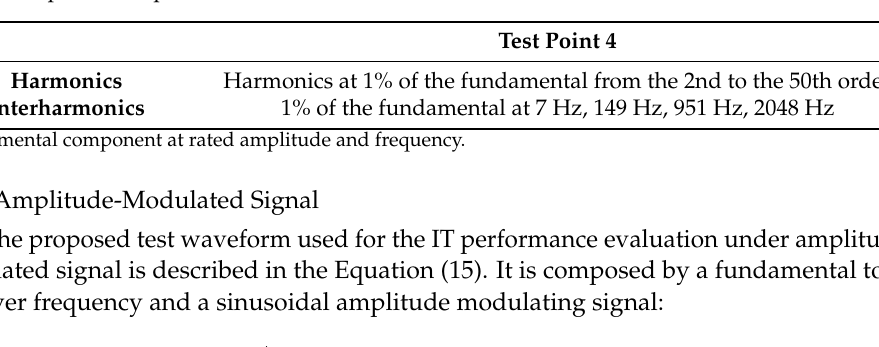
Table 7. Proposed test point for harmonics and interharmonics.